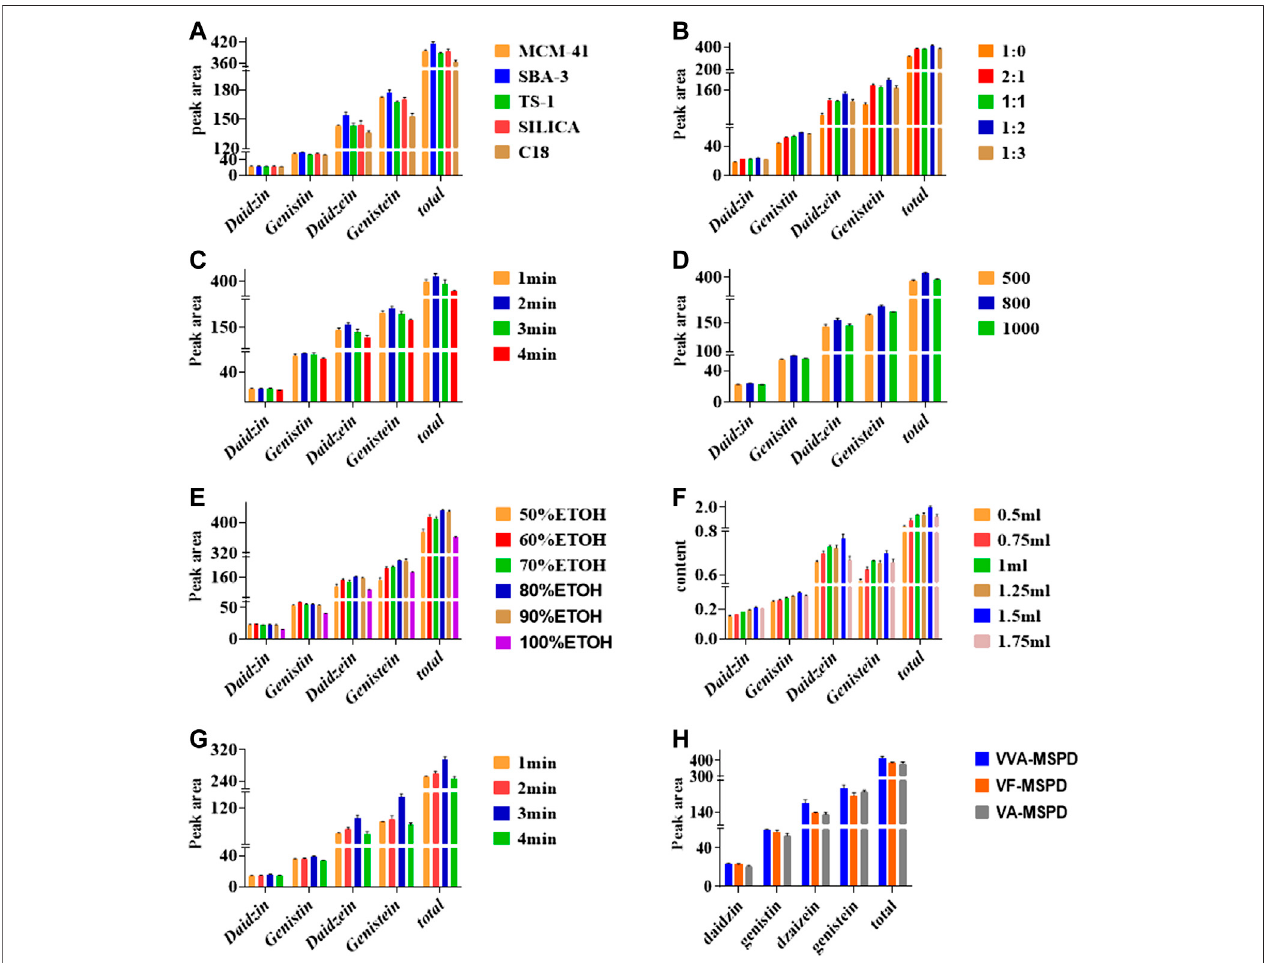
FIGURE 2 | Effects of parameters on extraction of four compounds by single factor using VVA-MSPD technique: (A) type of sorbent, (B) mass ratio of sample to sorbent, (C) crushing time of ball mill, (D) vibration frequency of ball mill, (E) Selection of Methanol with different concentration, (F) volume of eluting solvent, (G) vortex time, (H) comparison of VVA-MSPD with VF-MSPD and VA-MSPD method. The errors bars represent RSD ( n (cid:2) 3).